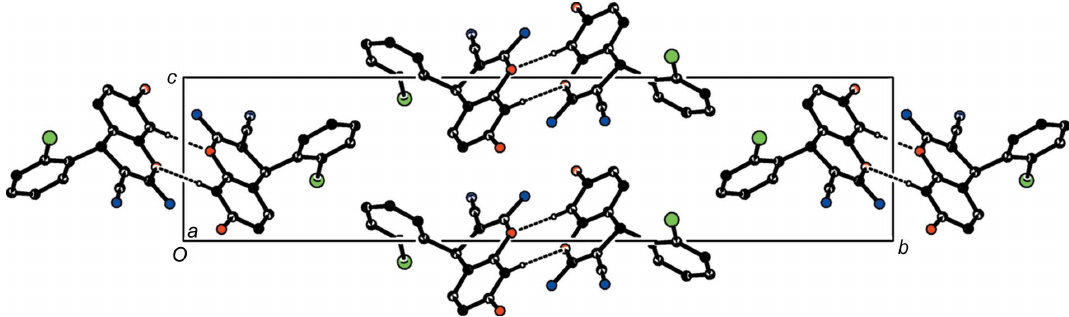
Figure 3 Part of the crystal structure showing the R 2